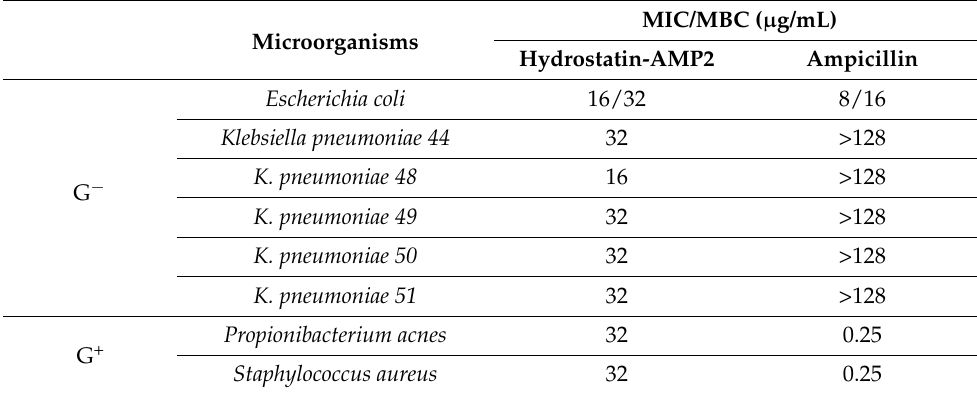
Figure 3. Molecular phylogenetic analysis of Hydrostatin-AMP2. The tree was obtained by neighbor- joining analysis based on the proportional difference of the signal peptide and cathelin domain sequence of Cathelicidins. Only bootstrap values >50% (expressed as percentages of 1000 resamplings) were shown. Hydrostatin-AMP2 was boxed. Table 1. Antimicrobial activity of